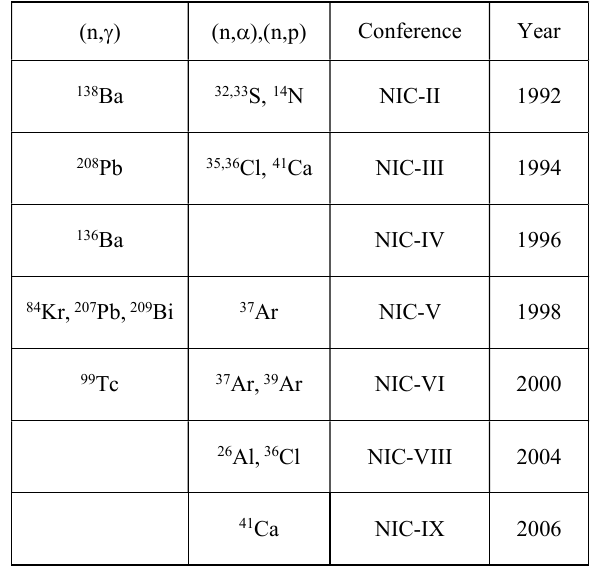
Table 1. Nuclear astrophysics contributions to Nuclei in Cosmos conferences with experimental data obtained at the GELINA